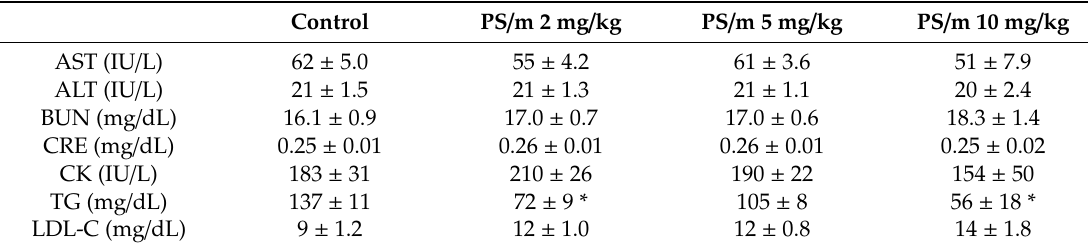
Figure 3. Experimental procedure and abdominal aortic aneurysm (AAA) treatments. ( a ) Experimental procedure of the elastase infusion model. Elastase infusion into the aorta is performed on day 0. Rats received an intravenous injection of the drug immediately after the operation and on days 2, 4, and 6. On day 7, the diameter of each aorta was measured, and it was resected for analysis. ( b , c ) Diameter of aortas on initial (day 0) and 7 days from the first administration. Control, PS/m 2 mg/kg, and PS/m 5 mg/kg groups: n = 7. PS/m 10 mg/kg group: n = 3. * p < 0.05. Error bars denote the standard error of the mean. ( d ) Cross sections of AAAs at 7 days, original magnification ×2. Scale bars: 1 mm. Table 2. Blood biochemical analysis on day